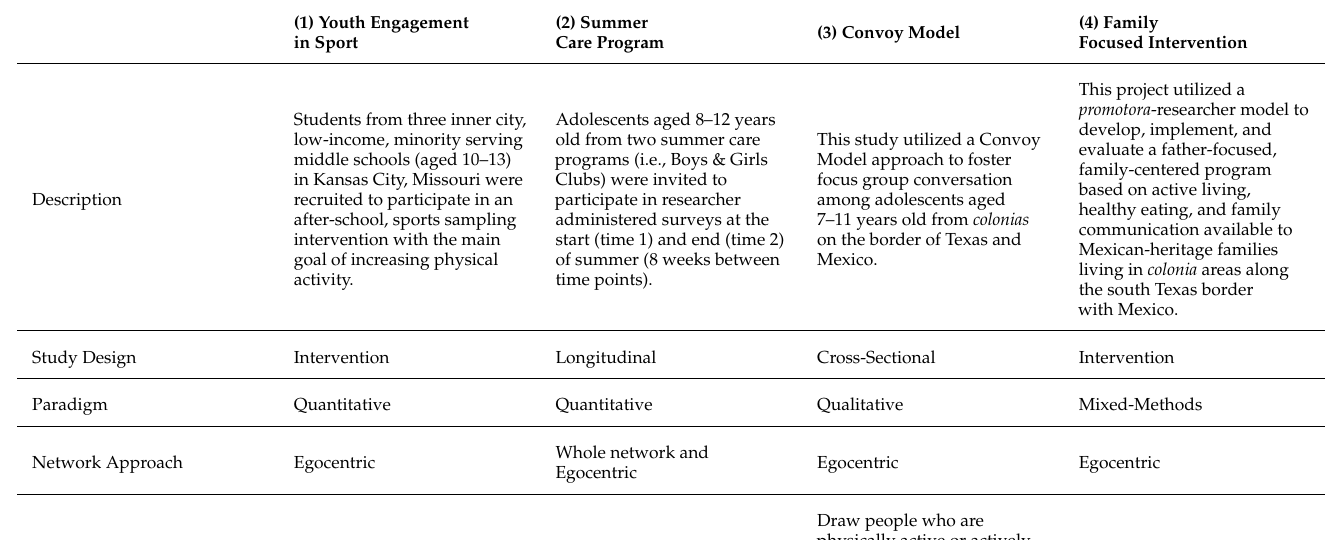
Table 2. Case study designs and sample